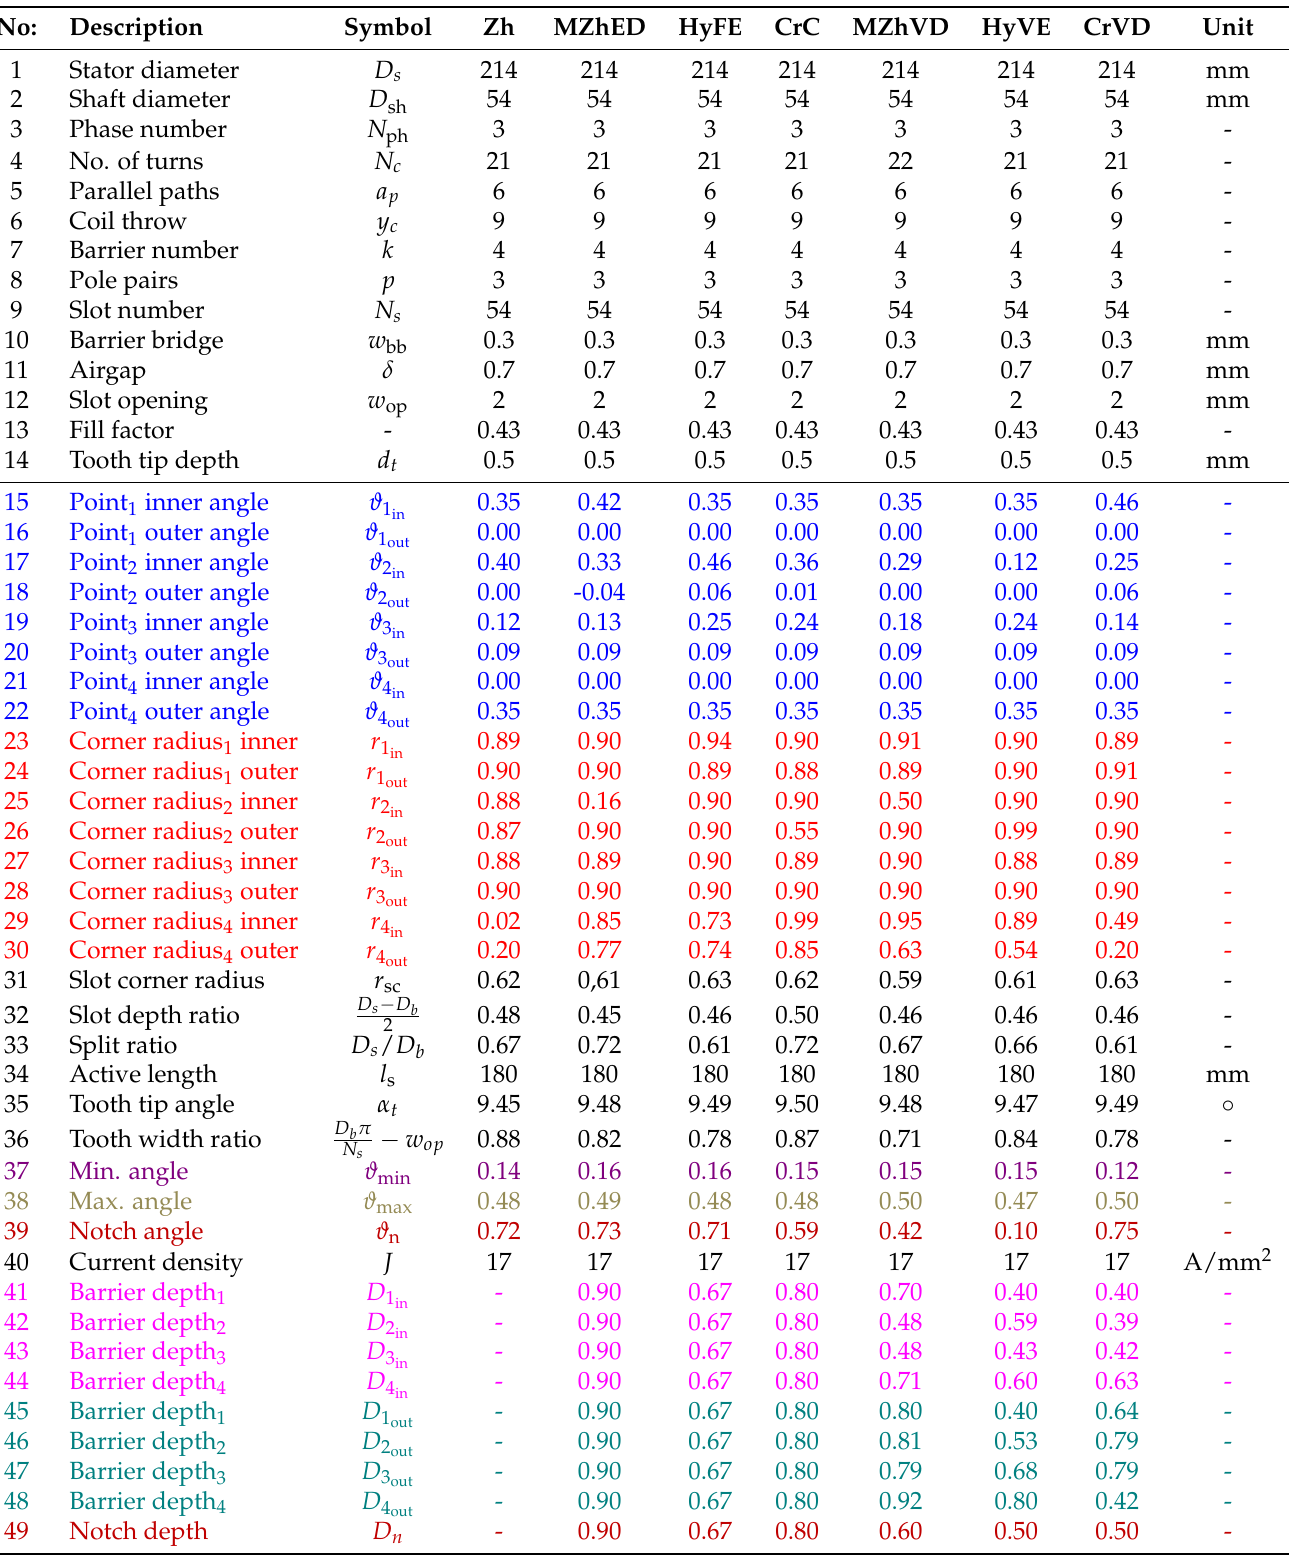
Table 6. List of all optimized parameters for design variants with k =